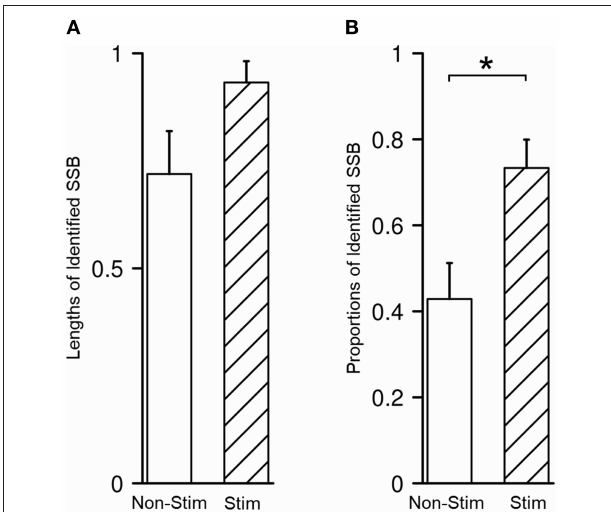
FIGURE 6 | Microstimulation promoted the identification of SSB. (A) There was no difference between the length of SSB in trajectories with and without microstimulation. (B) The proportion of identified SSB was significantly higher in trajectories with microstimulation than those without. SSB, boundary between subthalamic nucleus and substantia nigra. * P < 0.05.